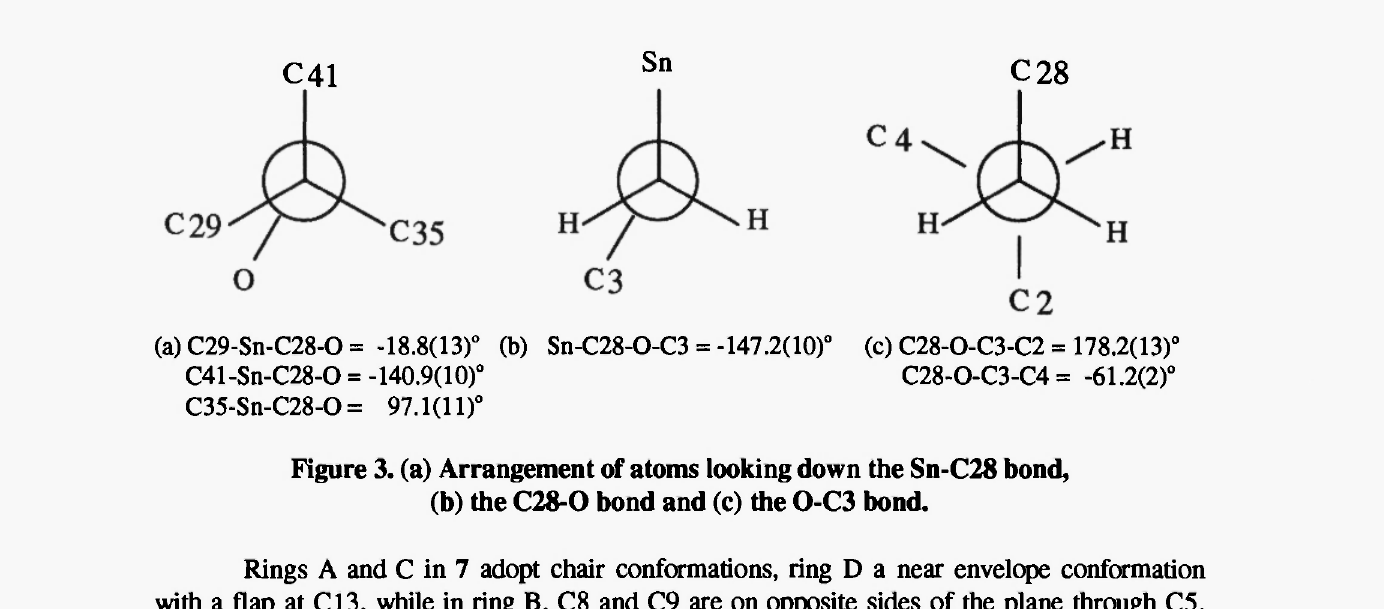
Figure 3. (a) Arrangement of atoms looking down the Sn-C28 bond, (b) the C28-0 bond and (c) the 0-C3